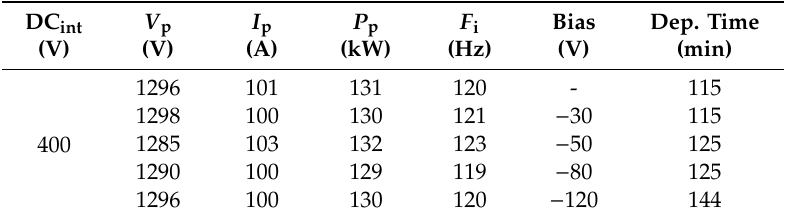
Table 1. Deposition conditions used to deposit tantalum thin films by deep oscillation magnetron sputtering (DOMS).